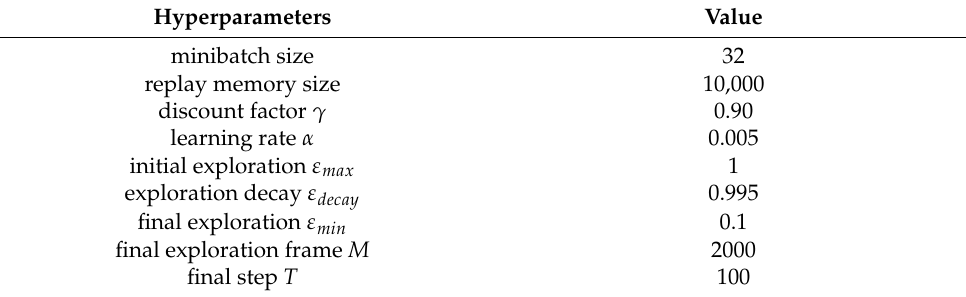
Figure 7. The average reward curves of the training process for different hyperparameter settings. (The results of simulation experiments). Table 3. List of hyperparameters and their